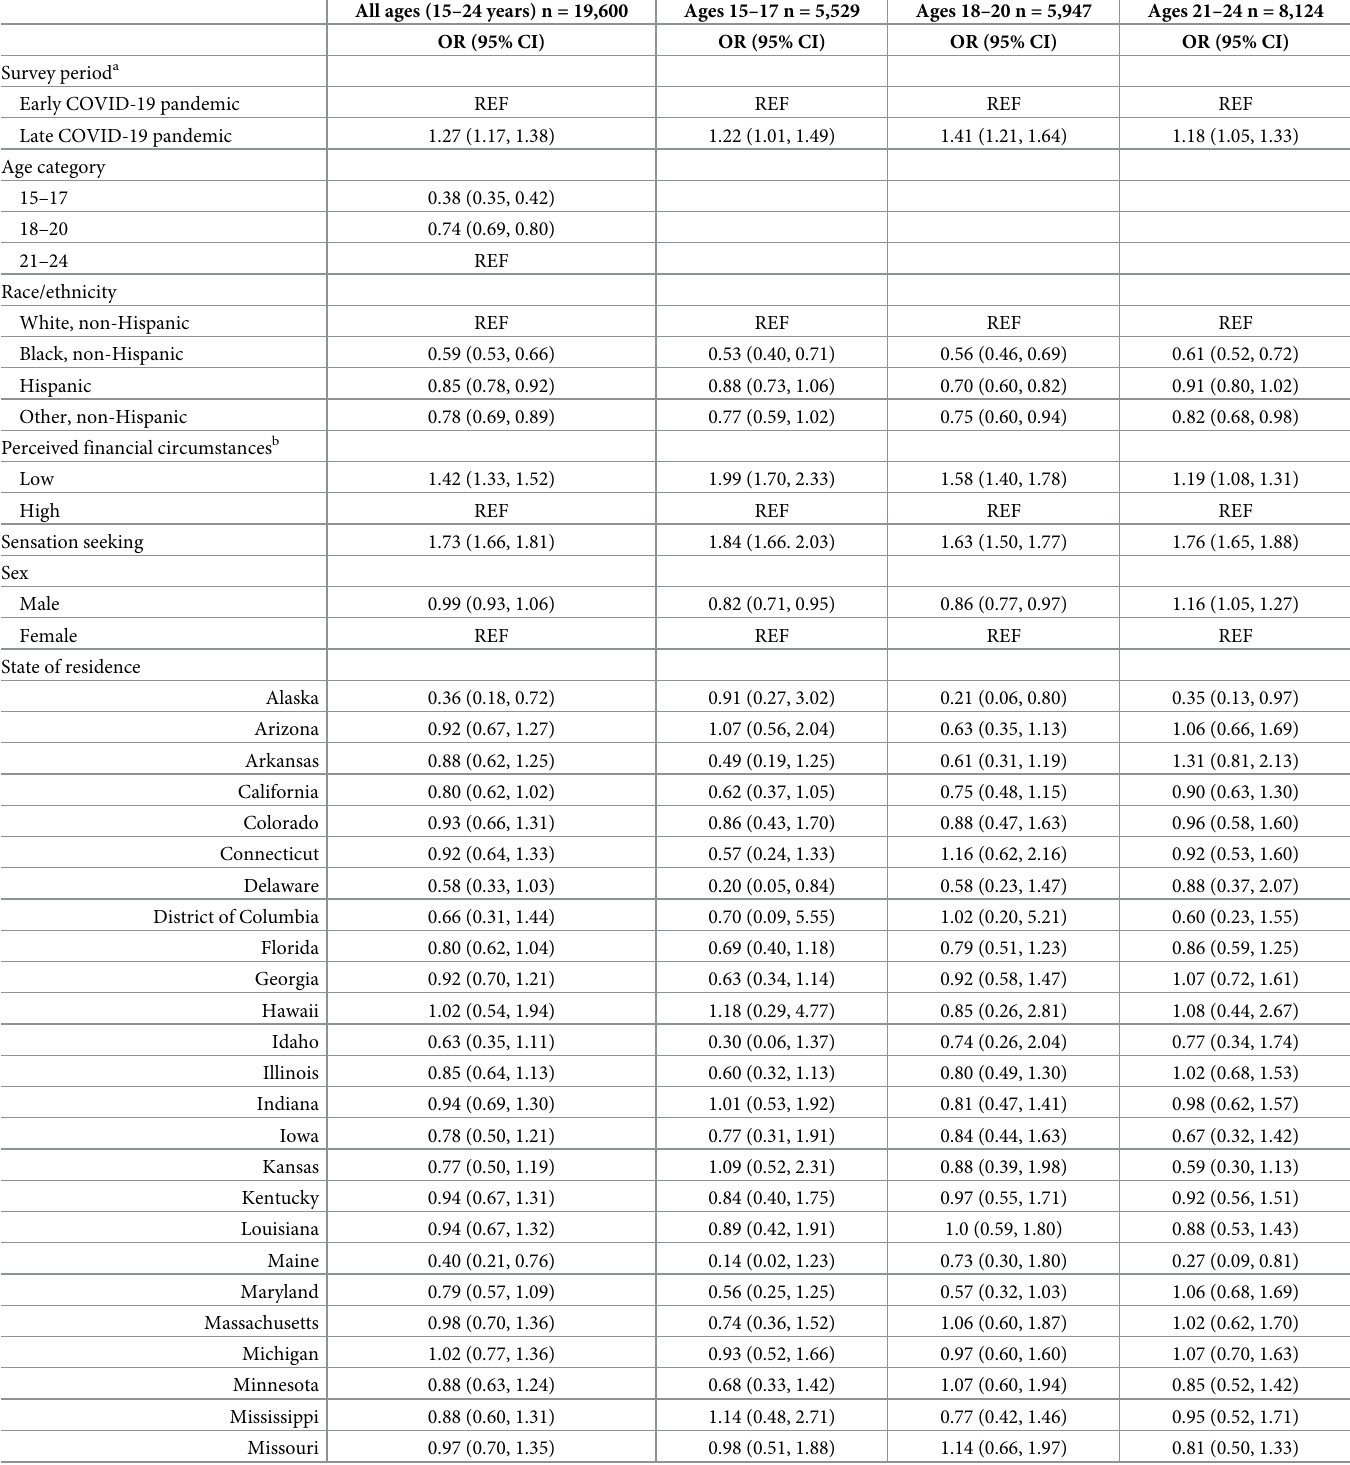
Table 2. Odds of past 30-day e-cigarette use late in the COVID-19 pandemic (April 2021– April 2022) compared to early in the pandemic (March–July 2020) among youth and young adults in the United States, age-adjusted or stratified by age